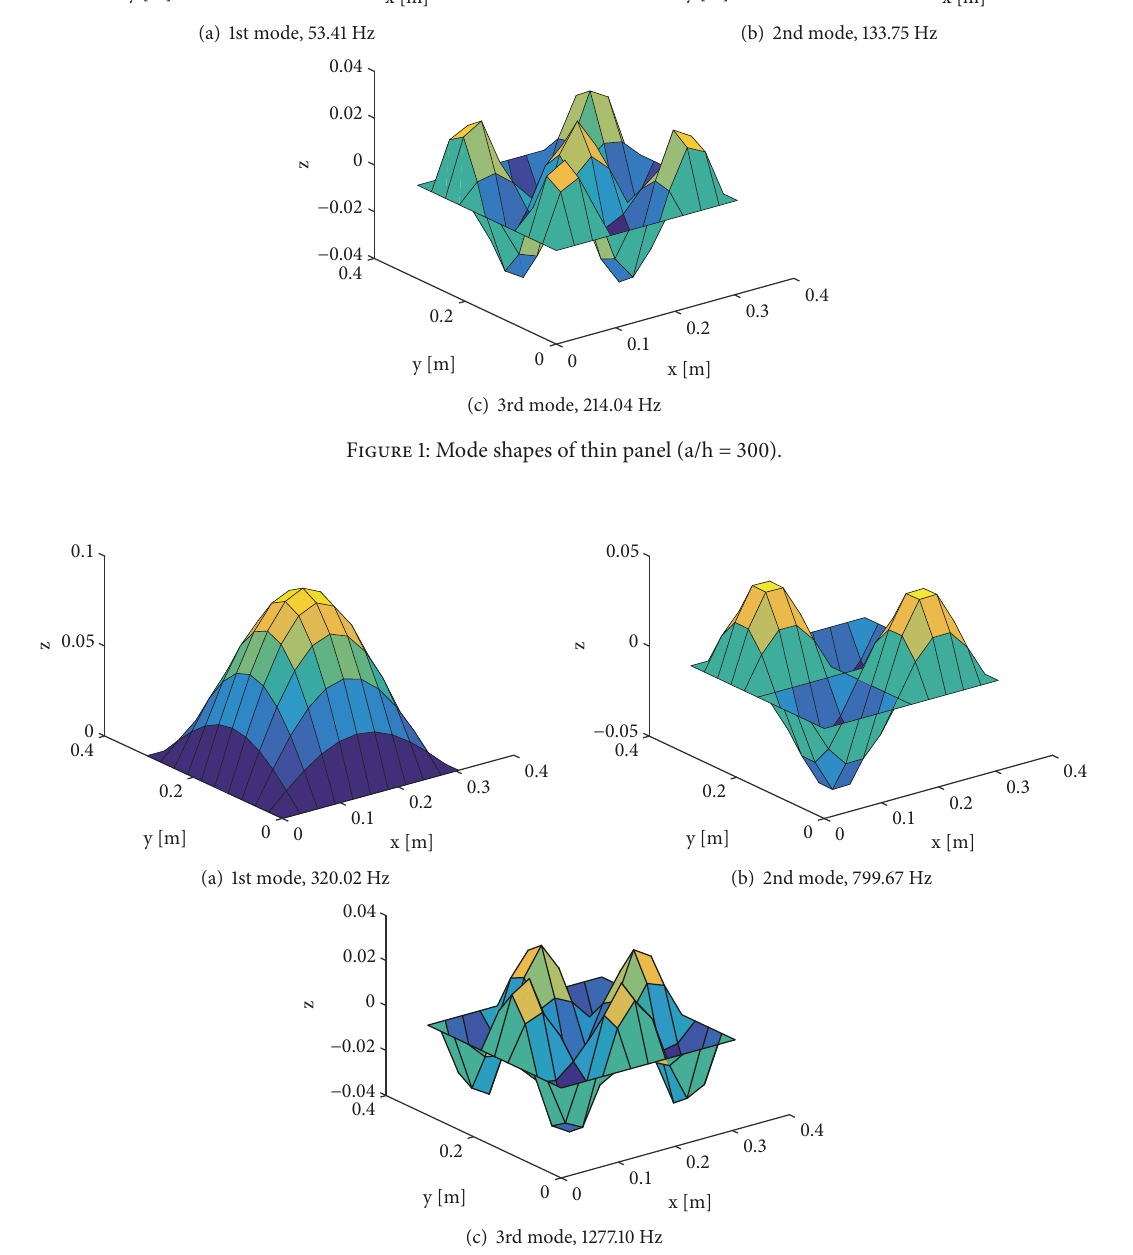
Figure 2: Mode shapes of thick panel (a/h =